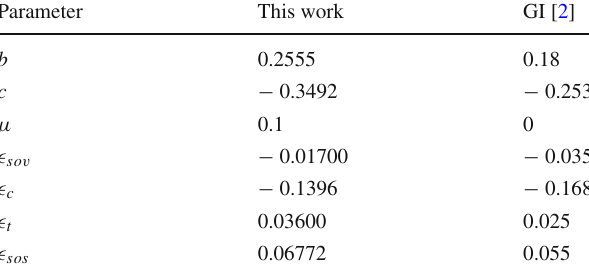
Table 1 Parameters and their values in this work and GI models